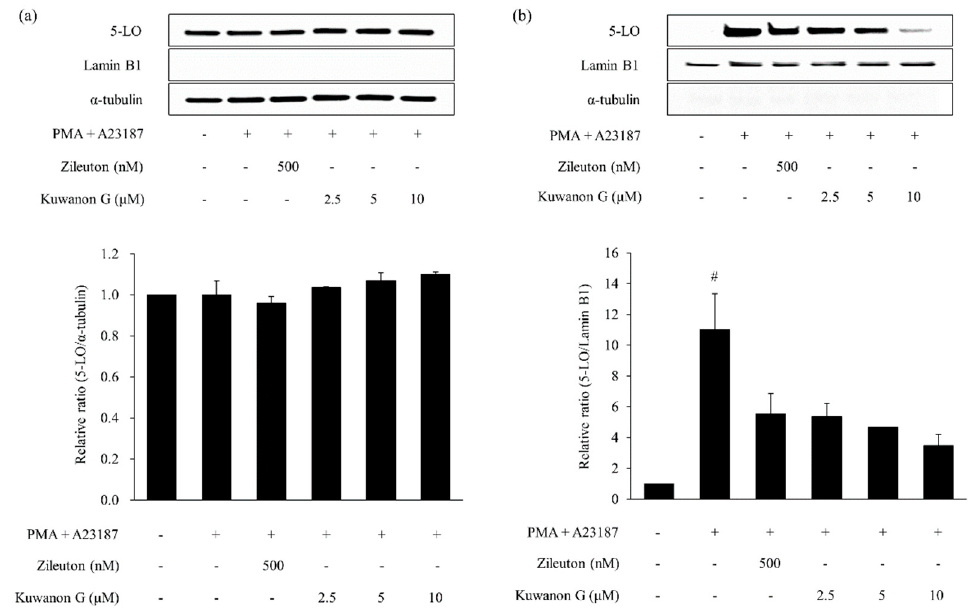
Figure 7. Effect of kuwanon G on PMA and A23187-induced 5-LO activation in MC/9 mast cells. Expression of cytoplasmic ( a ) and nuclear ( b ) 5-LO was determined by Western blotting. Zileuton was used as the positive control. Data are expressed as the mean ± SEM ( n = 2). # p < 0.01 versus vehicle control cells.